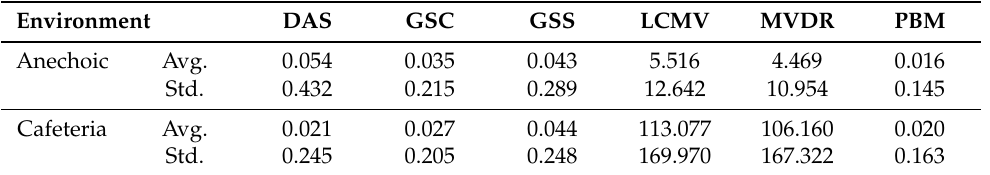
Table 2. Overruns triggered; average and standard